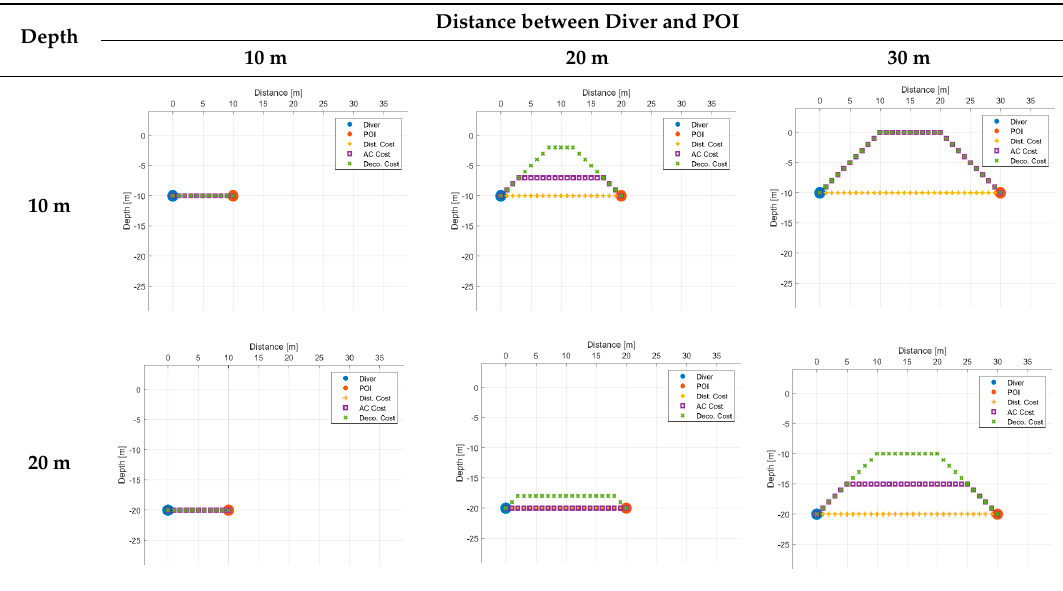
Table 5. Different behaviours of the strategies in suggesting the ascent by varying the depth and the distance between the diver and point of interest (POI).